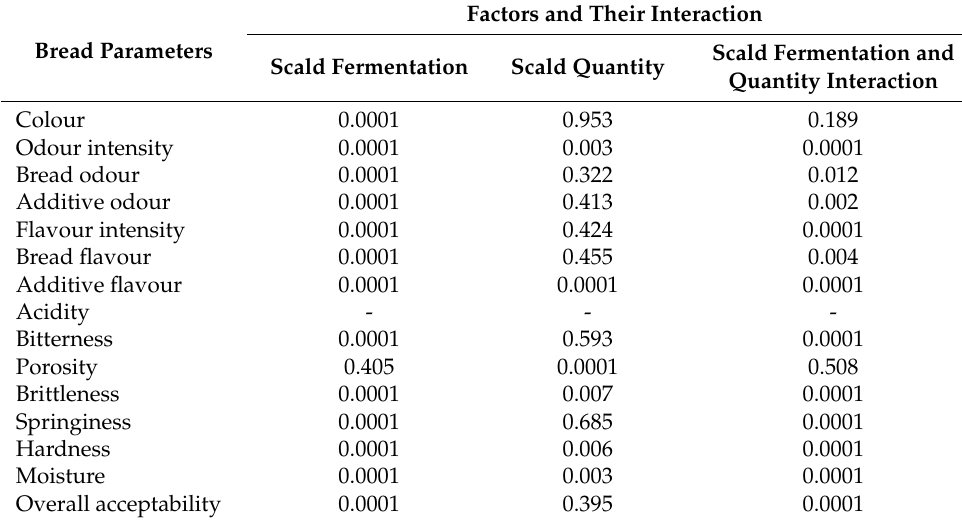
Figure 3. Bread sensory properties (( a , c ) — colour, taste, flavour and odour sensory characteristics; ( b , d ) — texture sensory characteristics; and ( e ) — overall acceptability; control — bread prepared with- out scald or fermented scald; Sc — scalded rye flour; FSc — scalded fermented rye flour; 5%, 10%, 15% — bread prepared with 5%, 10%, 15%, respectively, scalded or scalded-fermented rye whole- meal flour. Data expressed as mean values (n = 10) ± standard error (SE). a – e Mean values within columns with different letters are statistically significantly different ( p ≤ 0.05)). Table 7. Influence of analysed factors (fermentation and quantity of the scald, and their interaction) on bread sensory properties and overall acceptability.